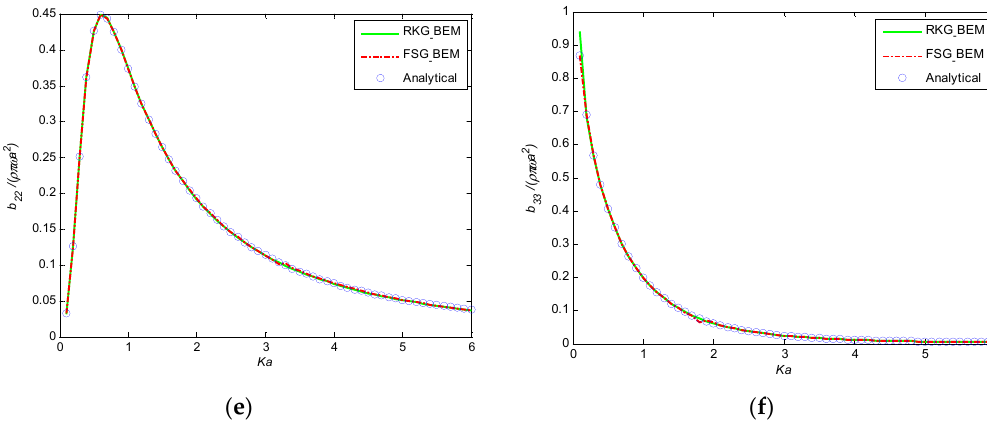
Figure 7. Comparison of hydrodynamic characteristics of a floating cylinder, in semi-immersed circle of radius a: ( a ) sway exciting force; ( b ) heave exciting force; ( c ) sway added mass; ( d ) heave added mass; ( e ) sway added damping; and ( f ) heave added damping. Table 1. Mesh specifications for the case shown in Figure 4. L F , L U , L L and L B denote the length of the boundaries as shown in Figure 1, respectively, and N F , N U , N L , and N B denote the number of elements meshed on the boundaries, respectively.